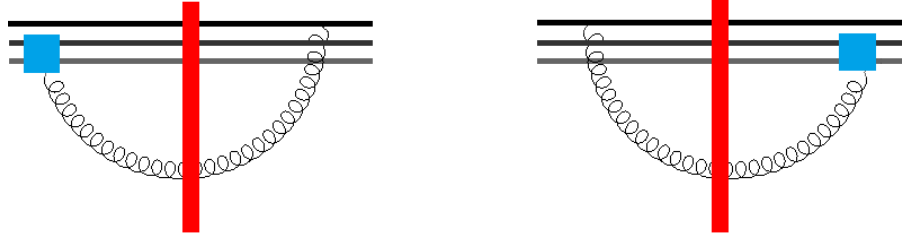
Figure 12 . The diagrams for (cid:6) JJSJ . E(cid:11)ective one gluon emission vertex corresponds to j g (cid:26)(cid:26) i .